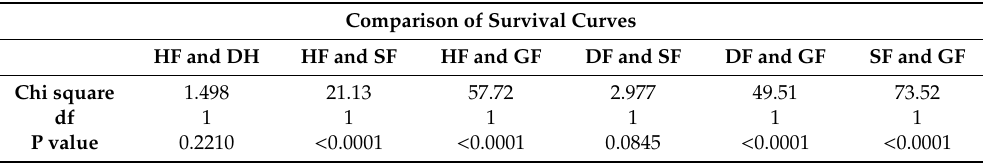
Table 1. Statistical data obtained from survival analysis.